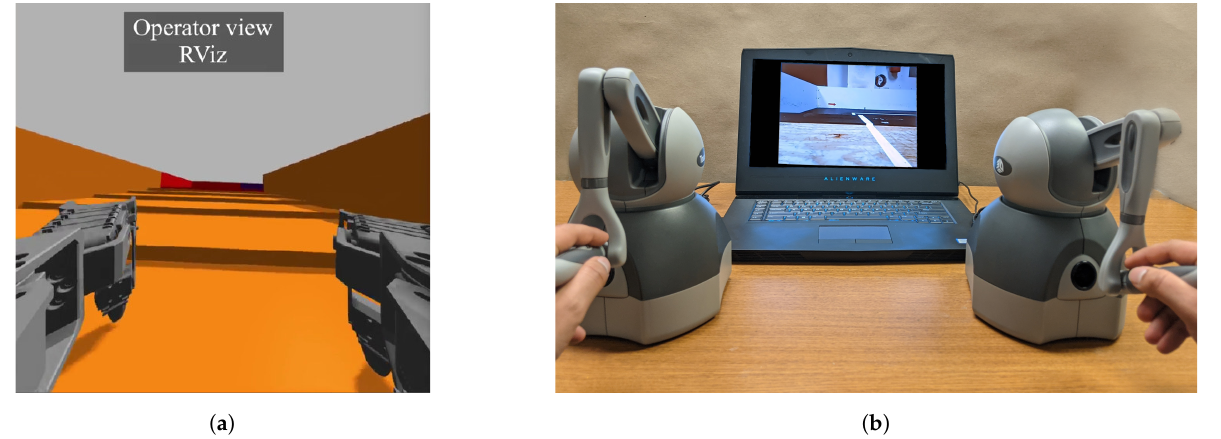
Figure 4. Typical visual feedback received by operator, rendered either from ( a ) a simulated streaming RGB camera mounted to the robot base or ( b ) the Raspberry Pi Camera V2 mounted to the physical robot. In both cases, feedback is rendered on a standard LCD